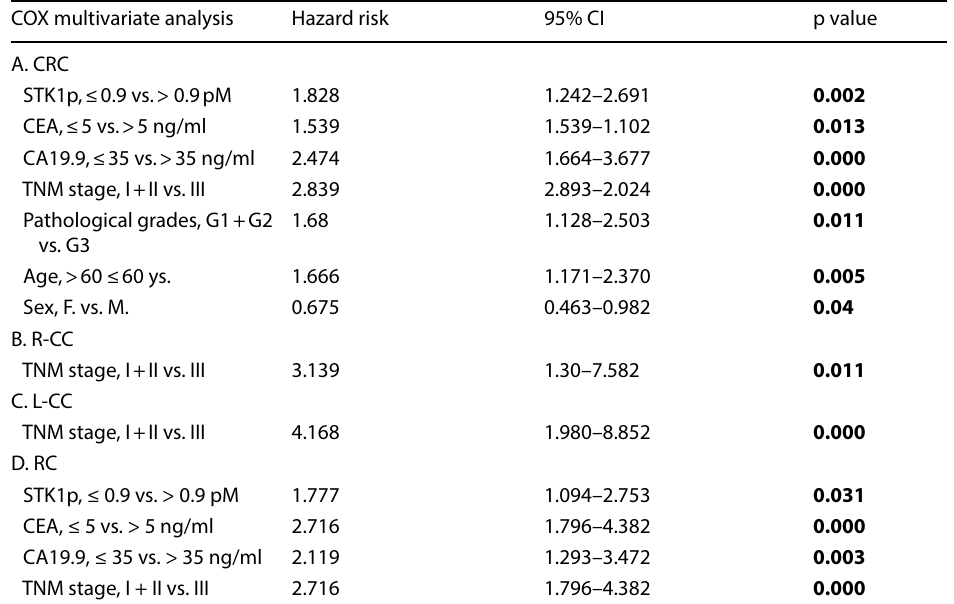
Black bold: P-values of < 0.05 were considered